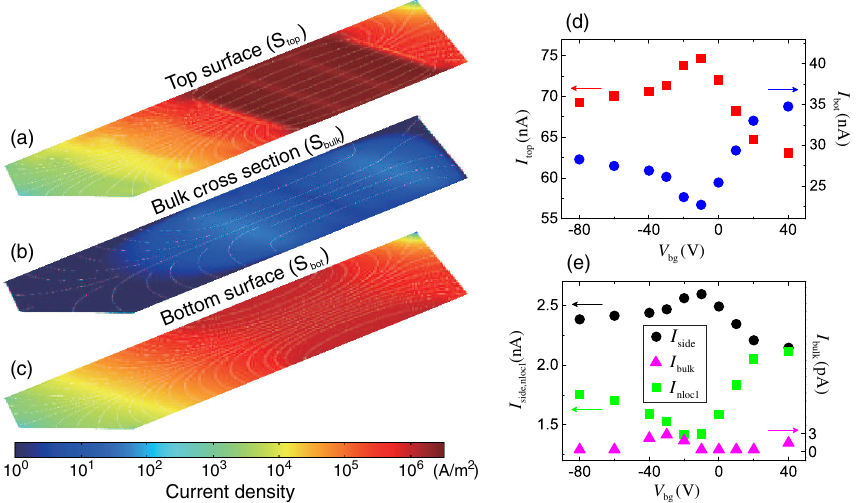
FIG. 4. (a),(b),(c) Numerical simulation results on the current distribution of our BSTS flake in Fig. 1(a). The current density profile at each plane, which is defined as in Fig. 3(a), is plotted using the same color scale for ð G top □ ; G bot □ Þ ¼ ð 6 . 0 ; 2 . 5 Þð e 2 =h Þ and σ ¼ 0 . 06 S = m, which correspond to the observed values of V ¼ 146 μ V, V ¼ 2 . 72 μ V, and V ¼ 0 . 58 μ V at 4.2 K bulk loc nloc 1 nloc 2 ¼ 0 V. The solid lines in (a), (b), and (c) are contour lines describing the current flow (i.e., these lines are perpendicular to the for V bg equipotential lines). (d) V dependence of I (red squares) [ I (blue circles)], the current on the top (bottom) surface at the bg top bot